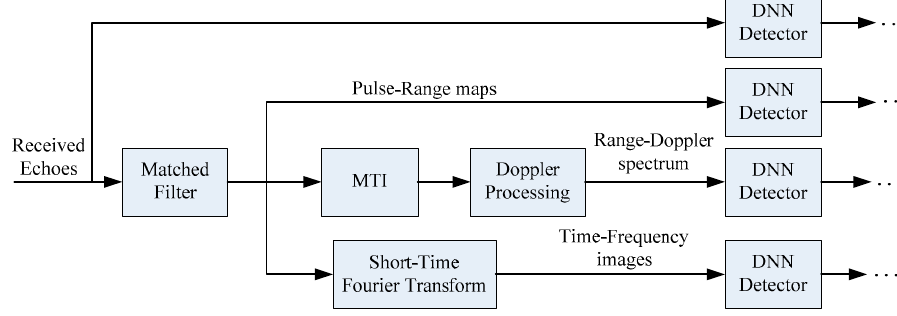
Figure 19. Preprocessing diagram of the dataset for the radar detection system.